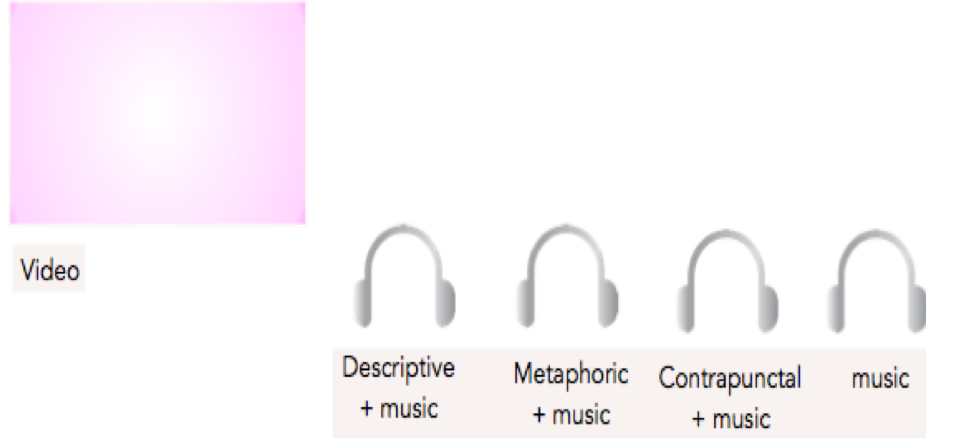
Figure 3 | Schematic of MediaScape